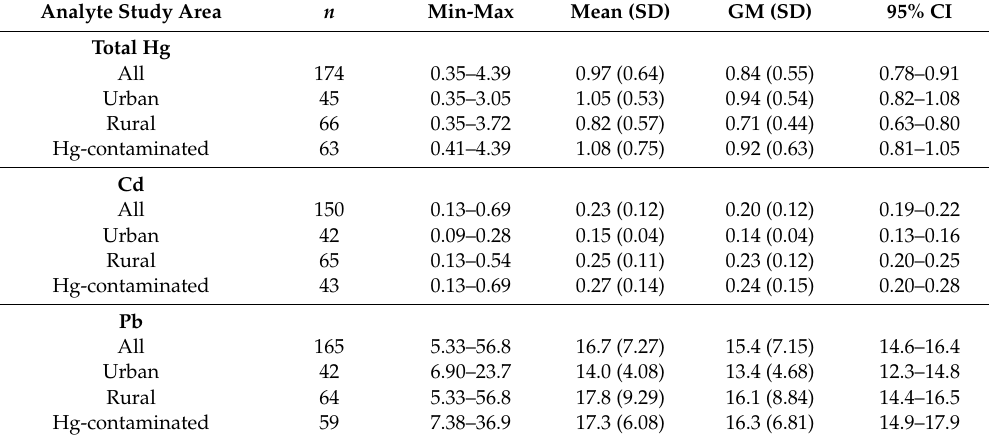
Table 2. Population variability: total levels of Hg, Cd, and Pb in the blood ( µ g / L) of 6- to 11-year-old children from three study areas in Slovenia. GM, geometric mean; Mean, arithmetic mean; min-max, range; n , sample size; 95% CI, 95% confidence intervals; SD, standard